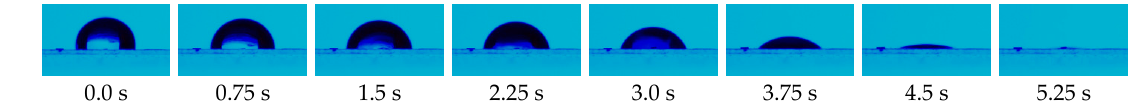
Figure 7. Selected images for the absorption process of water drop by the Ecoflex ® layer.